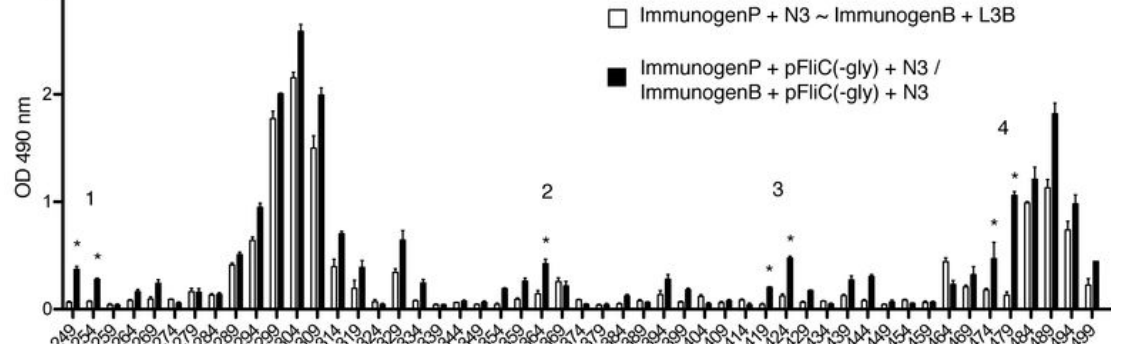
Figure 7. B cell epitope mapping to C2-C5 region of gp160 after immunization with gp160 with and without adjuvant. ELISA was performed using group-pooled serum (equal volumes) from immunization group 2 ( n = 35) or 4 ( n = 35) against individual peptides. Priming (ImmunogenP, plasmids) and boosting (ImmunogenB, rec proteins) groups are shown in the key. Immunization details are listed in Table 2. The concentration of gp160-peptide specific Abs are expressed as the end-point titers giving an OD equal to, or higher than, the mean + 3 SDs (the determined cutoff value for the assay) of the values of serum samples from unimmunized mice. Absorbance values equal to or above the cutoff value were considered positive. Statistical analyses were conducted using a two-tailed unpaired Student t test. * Differences of the responses between compared groups defined as p ≤ 0.05 were considered